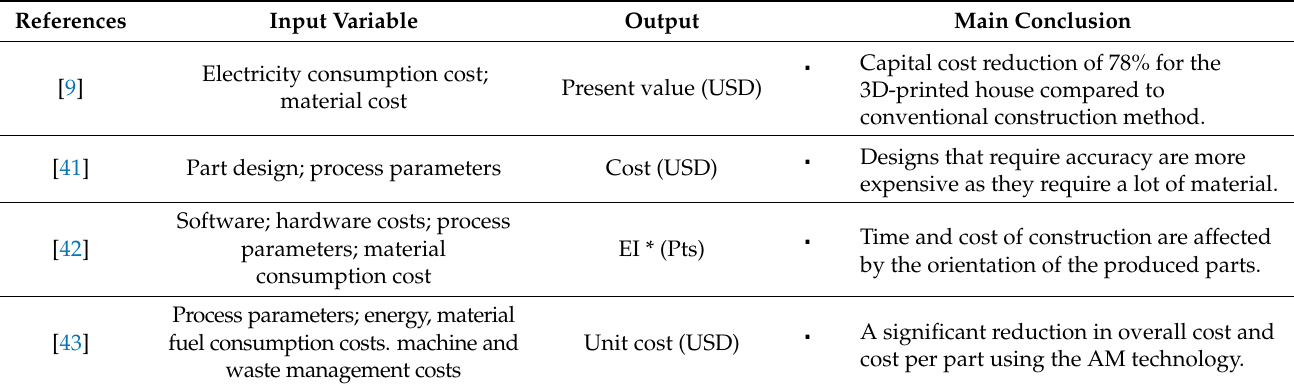
Table 3. Summary of the economics of 3DP technology in the